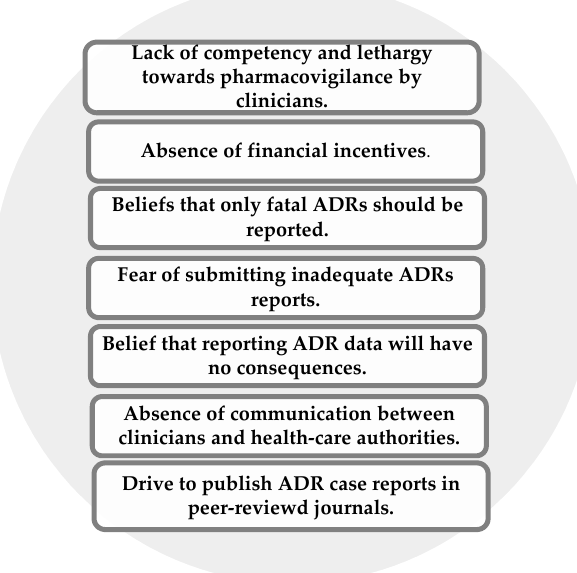
Figure 1. Main factors contributing to under-reporting of adverse drug reactions (ADRs) by clinicians in sub-Saharan African (SSA) countries.